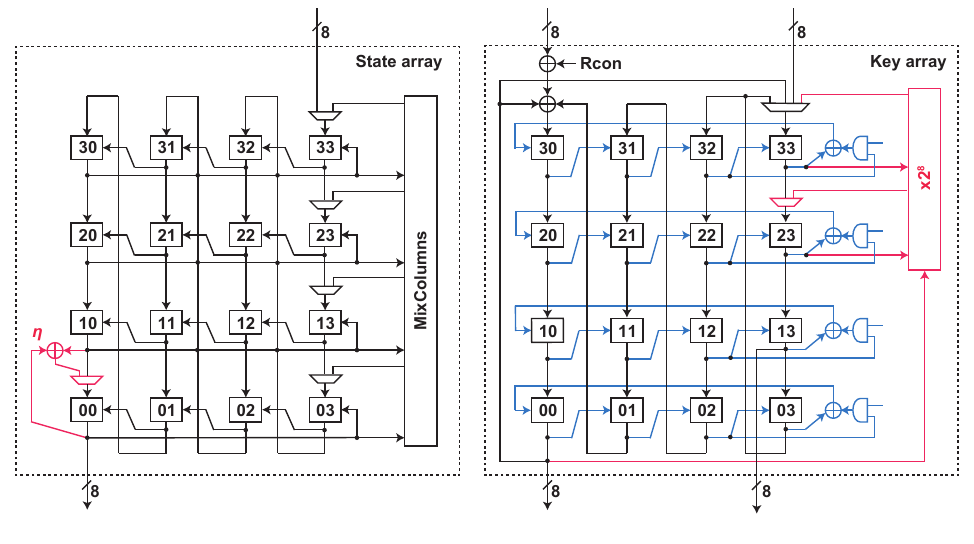
Figure 6: The state and key arrays used in the AES - LBBB implementation. We extended the basic arrays for column-oriented serialization (shown in black) with (i) the inverse key schedule (shown in blue, see Section 5.5.2) and (ii) the linear-update functions for the mode of operation (shown in red, η and × 2 8